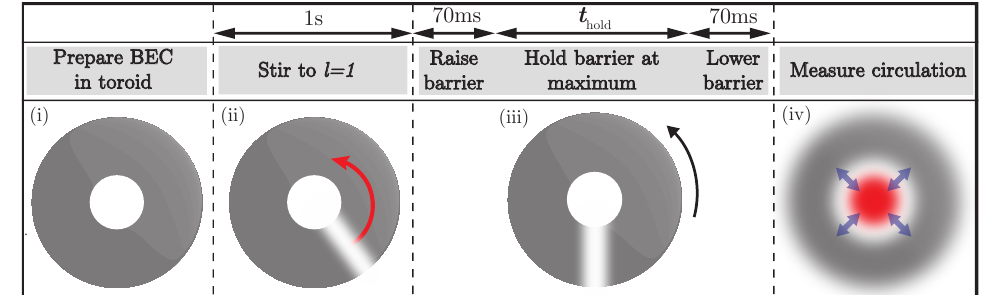
Figure 1: Schematic of the key steps in the experimental procedure of Ref. [ 15 ]